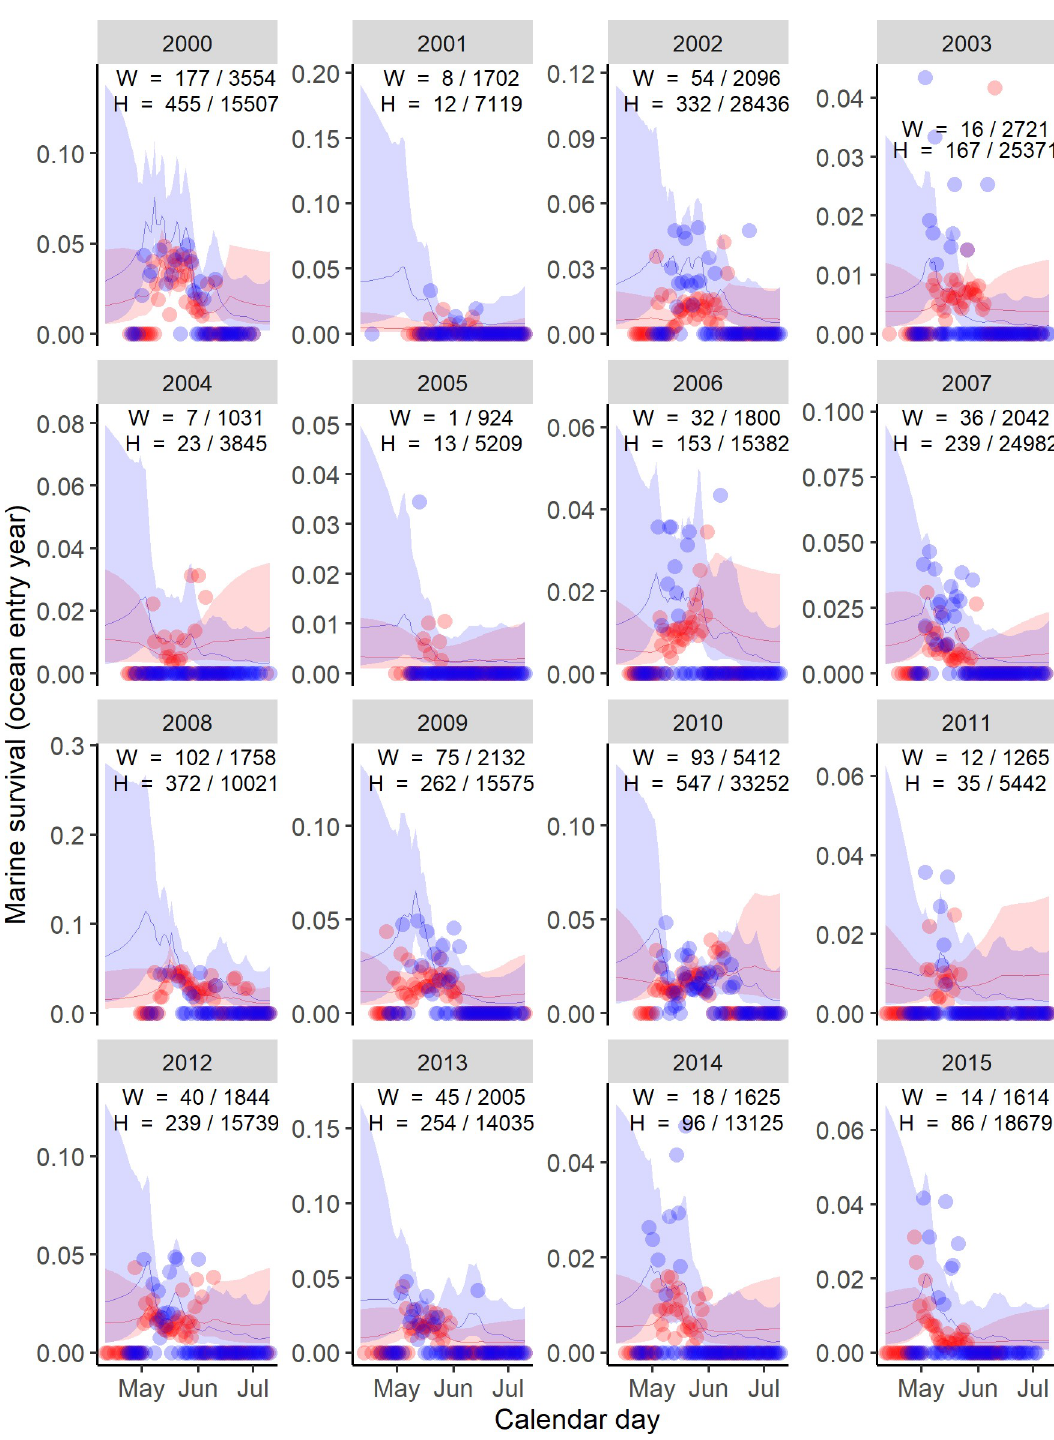
Fig 3. Predicted survival of spring/summer Chinook salmon from the Columbia River. The observed (dots), and maximum likelihood estimates (line) with 95% confidence intervals (ribbons) for the marine survival wild (blue) and hatchery (red) origin Spring/Summer Chinook salmon past Bonneville dam from 2000 to 2015. Each point represents the mean survival of all fish detected at Bonneville Dam on a particular day and year. Annual samples sizes of the survivors and total PIT tagged hatchery (H) and wild (W) for are shown in each panel. To maintain the readability of individual panels, mean observed survivals greater than 0.2 are not plotted.